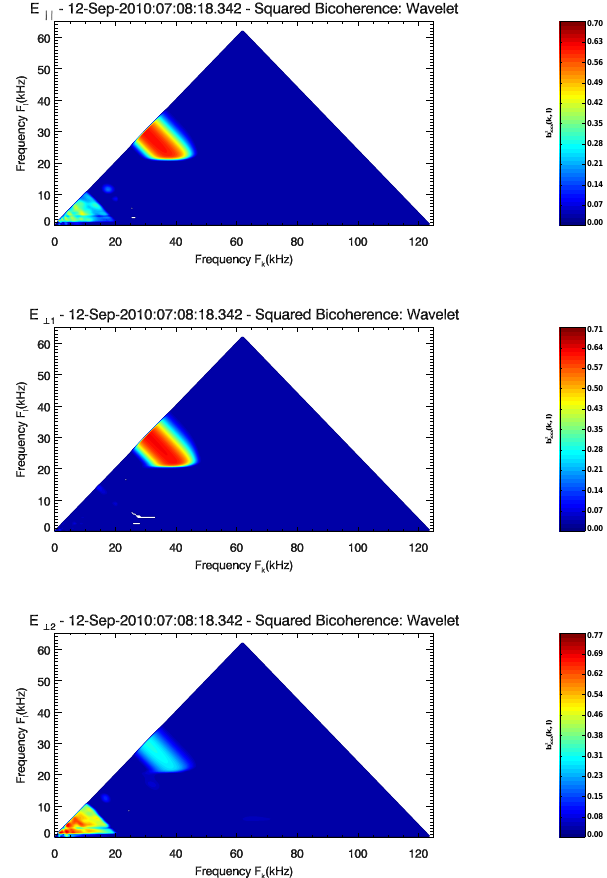
Fig. 7. The wavelet-based bicoherence spectra of the parallel and perpendicular components of the TDS event of Fig. 3. The bicoher- ence spectra of these components show peak values of ∼ 0 . 7, ∼ 0 . 7 and ∼ 0 . 3 at ( ∼ 30 ∼